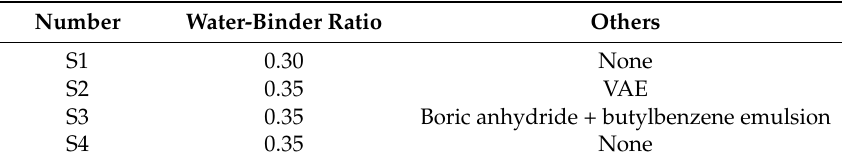
Table 9. Compressive and flexural strength of 7d